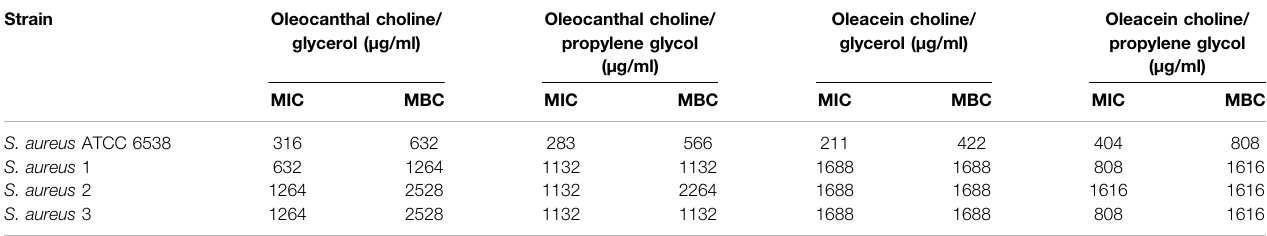
TABLE 6 | Antibacterial activity of oleocanthal and oleacein in NaDESs against Gram-positive standard strains and drug-resistant clinical isolates. Strain